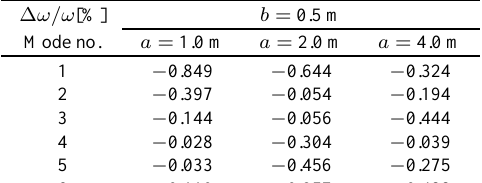
Table 3 Cantilevered beam: Eigenpulsation variations for b =